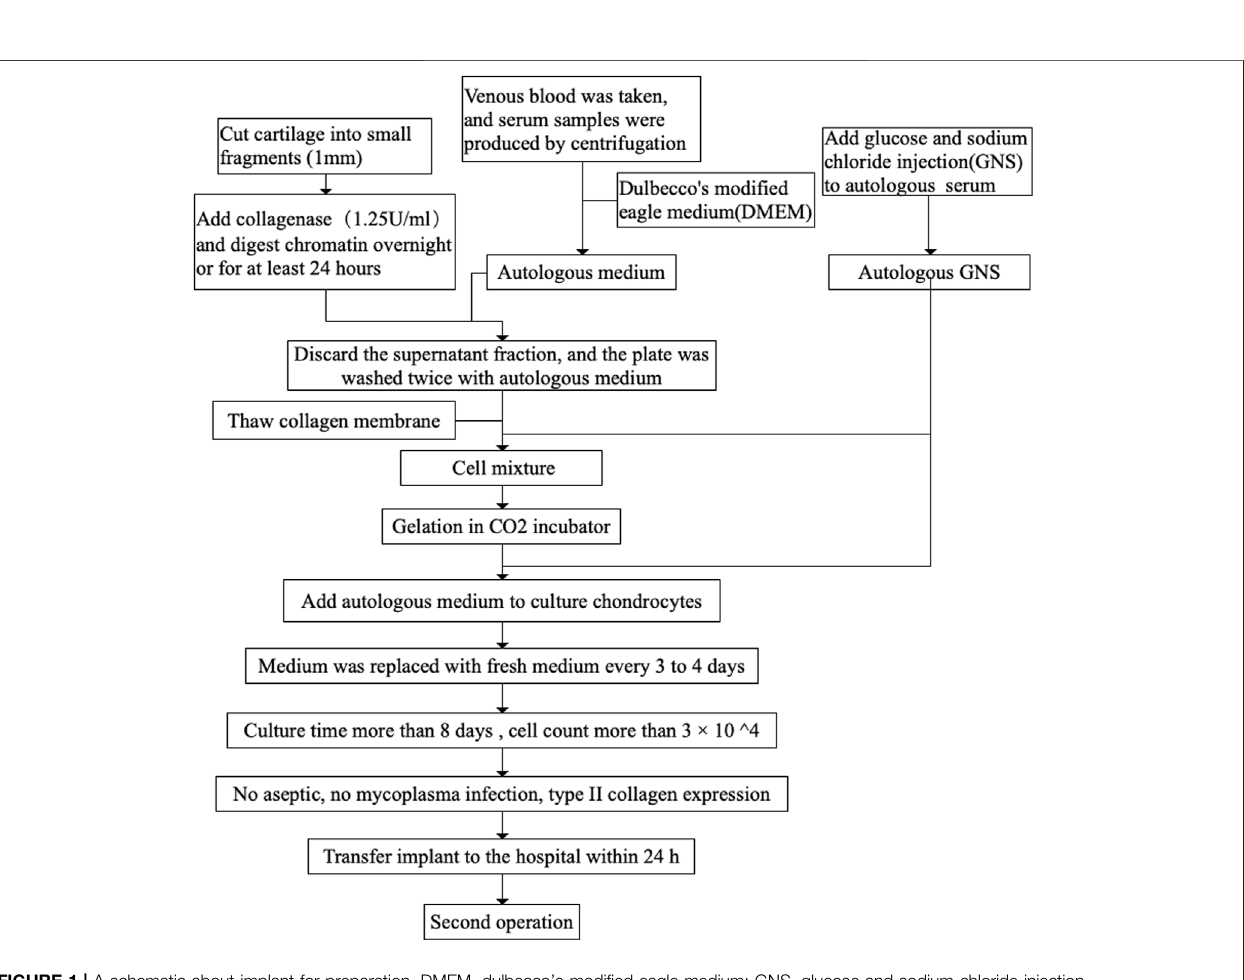
Frontiers in Bioengineering and Biotechnology |